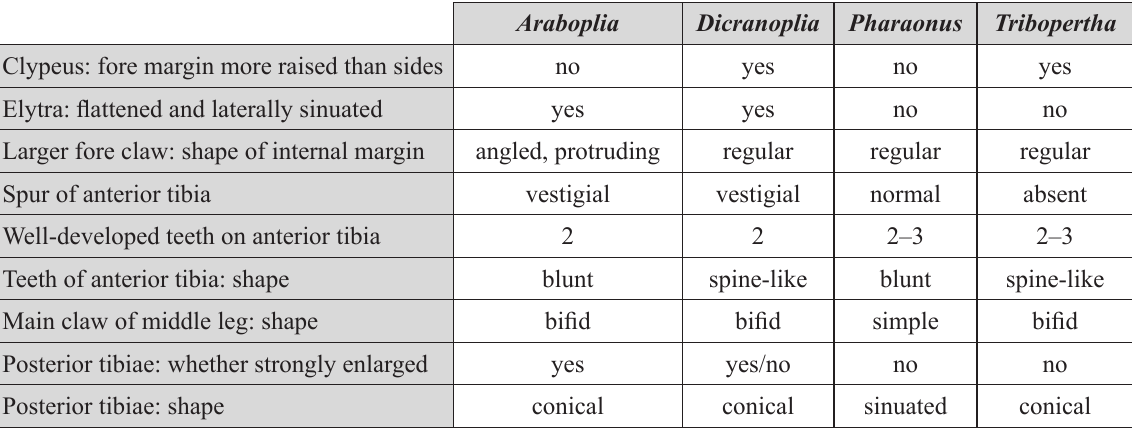
Table 1. Summary of states of diagnostic characters in males of Araboplia gen. nov. and the three closest genera. Araboplia Dicranoplia Pharaonus Tribopertha Clypeus: fore margin more raised than sides no yes no yes Elytra: flattened and laterally sinuated yes yes no no Larger fore claw: shape of internal margin angled, protruding regular regular regular Spur of anterior tibia vestigial vestigial normal absent Well-developed teeth on anterior tibia 2 2 2–3 2–3 Teeth of anterior tibia: shape blunt spine-like blunt spine-like Main claw of middle leg: shape bifid bifid simple bifid Posterior tibiae: whether strongly enlarged yes yes/no no no Posterior tibiae: shape conical conical sinuated